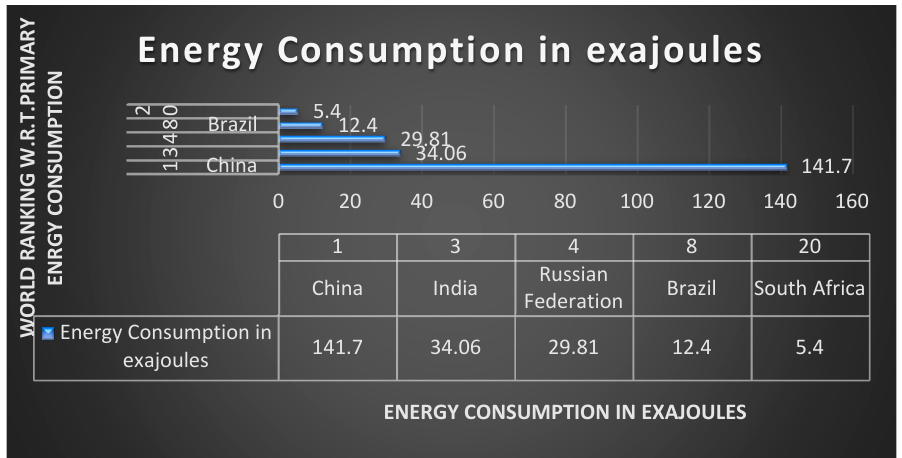
Figure 1. Energy consumption in exajoules. (available online: www.statista.com, accessed on 16 June 2021).